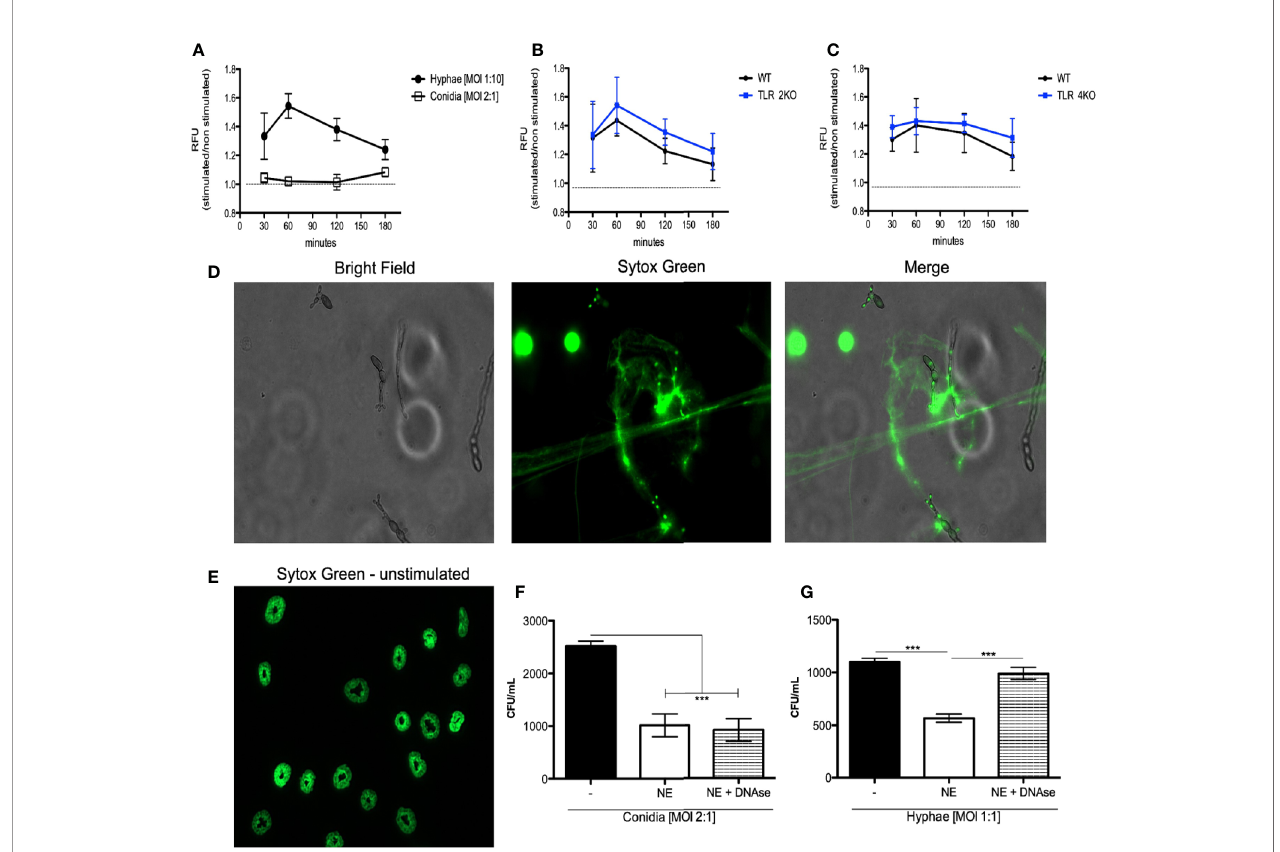
FIGURE 4 | NET release against F. pedrosoi hyphae infection is a mechanism independent of TLR-2 and TLR-4 and responsible for hyphae killing. (A) WT neutrophils puri fi ed by magnetic beads were resuspended in media containing 5µM styox green dye in resting condition (dashed lines; negative control) or incubated with F. pedrosoi hyphae or conidia. Florescence was recorded by a plate reader for every 30min up to 3h. DNA release (NETotic index) shows NETosis over hyphae but not conidia infection (A) . After 180 min, the neutrophils incubated with hyphae were fi xed with 4% (v/v) PFA for 15min and analyzed by immuno fl uorescence microscopy ( D e E ). Using TLR-2KO (B) and TLR-4KO (C) neutrophils, we veri fi ed that NET release is a mechanism independent from TLR-2KO and TLR-4KO. To con fi rm that NETs kill F. pedrosoi hyphae (F) but not conidia (G) , WT-puri fi ed neutrophils were incubated with F. pedrosoi conidia or hyphae in the presence or absence of DNase. After 2 h, the cells were lysed with distilled water and seeded in Sabouraud agar at 37°C for 5 days. Data are expressed as mean ± SEM; n =5, two-way ANOVA with Bonferroni ’ s posttest. *** p